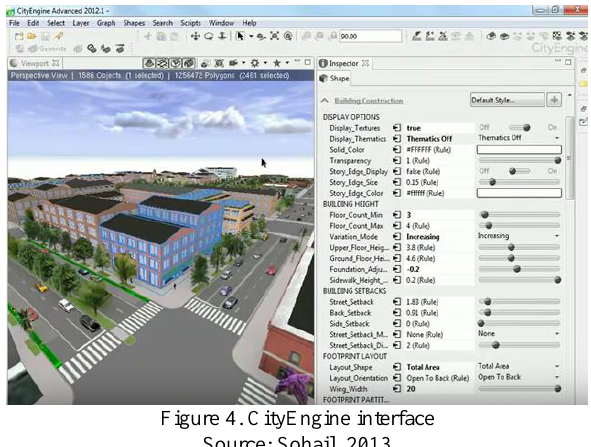
Figure 4. CityEngine interface Source: Sohail,